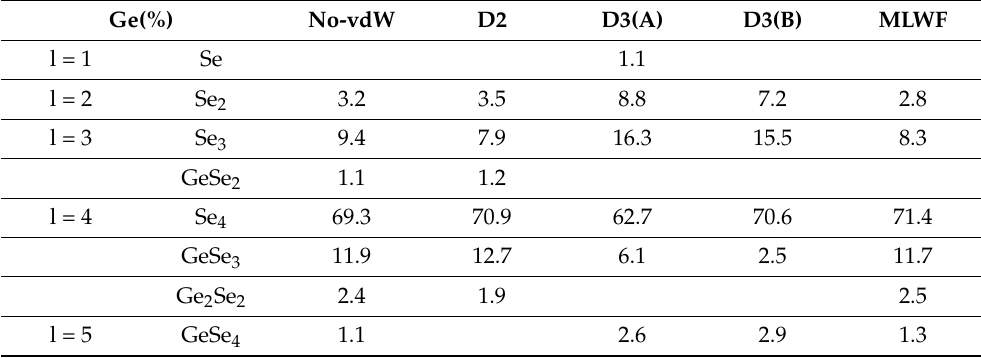
Table 2. Structural units composing the Ge-based subnetwork of liquid GeSe 4 . The values given are the percentages of Ge atoms connected in onefold, twofold, threefold, fourfold, and fivefold fashion, the chemical nature of the different neighbors being specified in the second column.